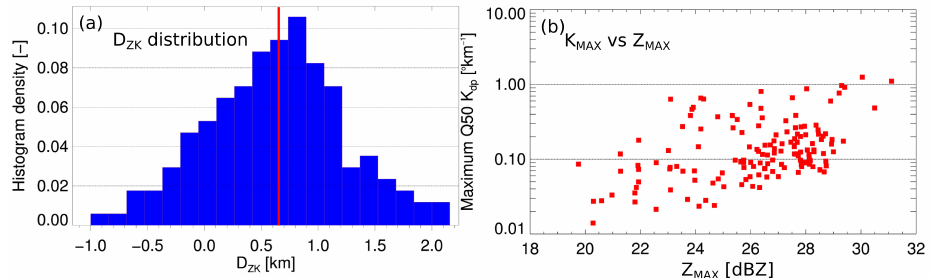
Figure 8. (a) Frequency distribution (i.e., sample histogram) of D zk (km) values. (b) Scatterplot of K MAX ( ◦ km − 1 ) vs. Z MAX (dBZ). The graphs are calculated for all the time intervals listed in Table 2, and the quantities displayed are shown in Fig. 6.